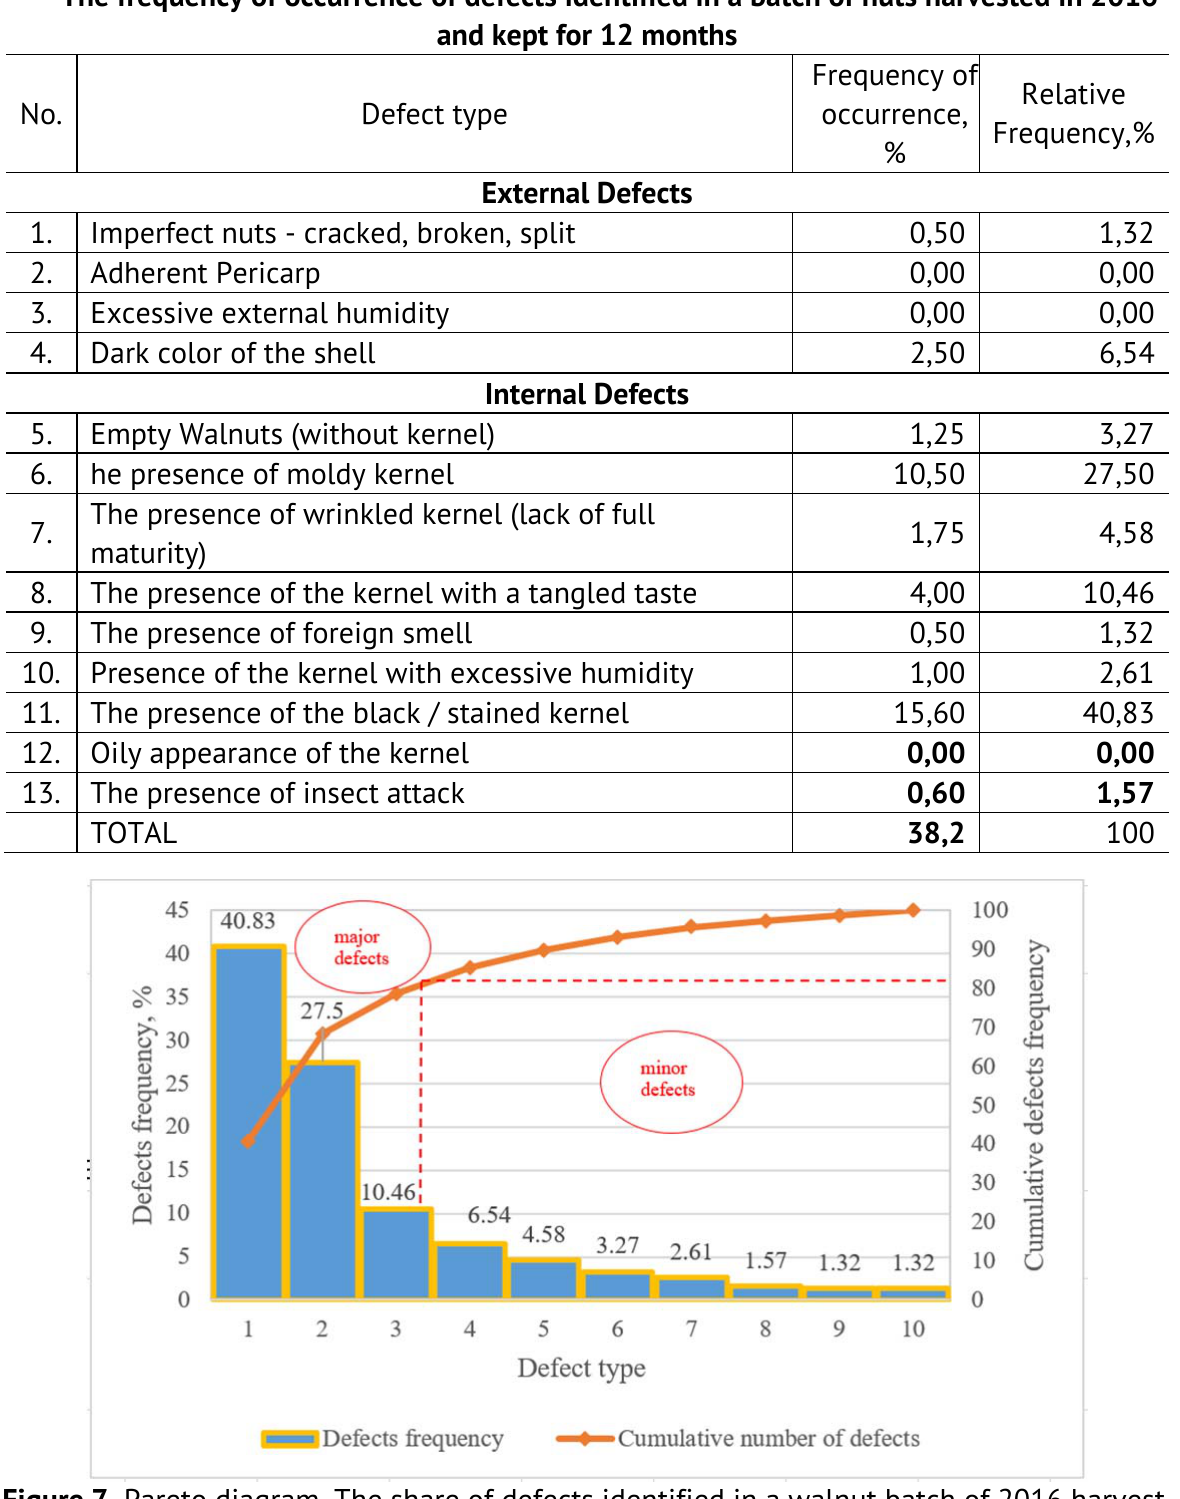
Figure 7. Pareto diagram. The share of defects identified in a walnut batch of 2016 harvest, stored for 12 months. 1 - The presence of the black / stained kernel, 2 - The presence of moldy kernel, 3 - The presence of the kernel with a tangled taste, 4 - Dark color of the shell, 5 - The presence of wrinkled kernel (lack of full maturity), 6 - Empty Walnuts (without kernel), 7 - Presence of the kernel with excessive humidity, 8 - The presence of insect attack, 9 - The presence of foreign smell, 10 - Imperfect nuts - cracked, broken,